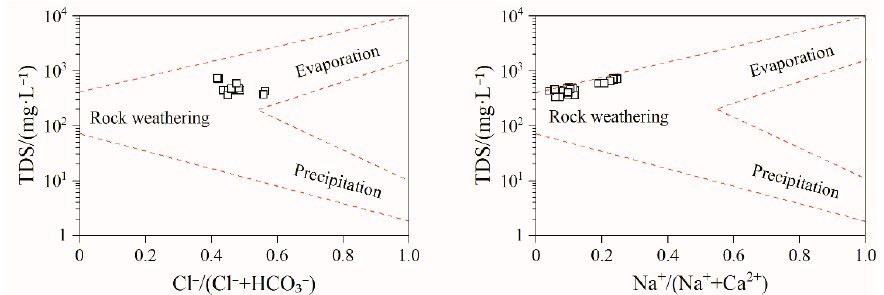
Figure 5. Gibbs plot of Sr-rich groundwater.